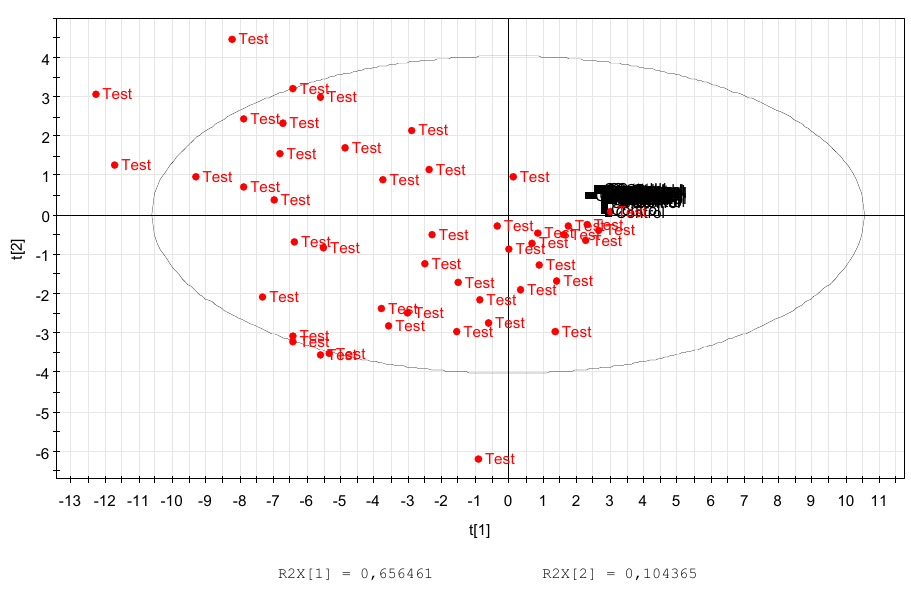
Figure 3. PLS ‐ DA score of 34 noted features performed using SIMCA P12 software. The distribution shows a significant difference and individual variation after drinking the juice.